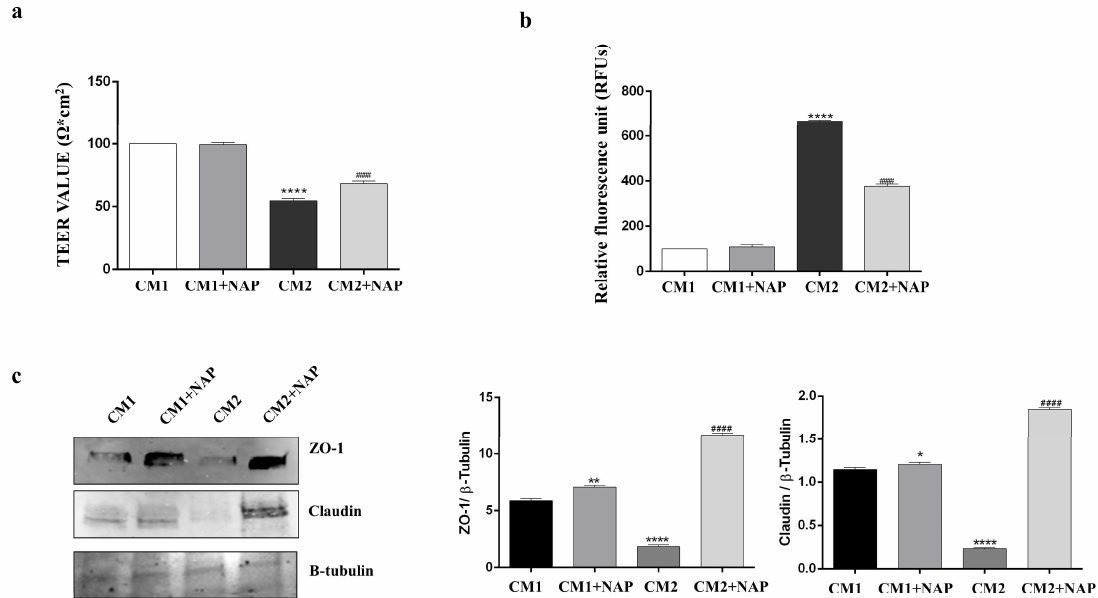
Figure 4. NAP attenuates the UV-B-induced barrier alterations of corneal epithelial cells. TEER ( a ) and permeability assays ( b ) were performed in SIRC cells grown on transwell clear permeable supports in either normal conditions (CM1) or with NAP (10 nM) (CM1+NAP), or cultured with either CM2 alone or with NAP (CM2 + NAP). Results are expressed as the mean ± SD. **** p < 0.0001 vs. CTRL; ### p < 0.001 vs. UV-B. ( c ) Expression of ZO-1 and claudin tight junction. The bar graphs show a quantitative analysis of signals obtained by immunoblots resulting from three independent experiments. Data represent means ± SD. * p < 0.05. ** p < 0.01 and **** p < 0.0001 vs. CM1; #### p < 0.001 vs.